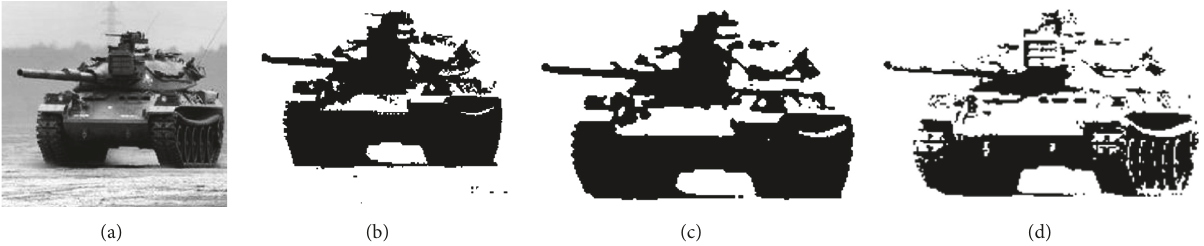
Figure 7: Segmentation of tank image. (a) Horse original. (b) Segmentation of one-dimensional Otsu. (c) The traditional two-dimensional Otsu method. (d) Our algorithm.